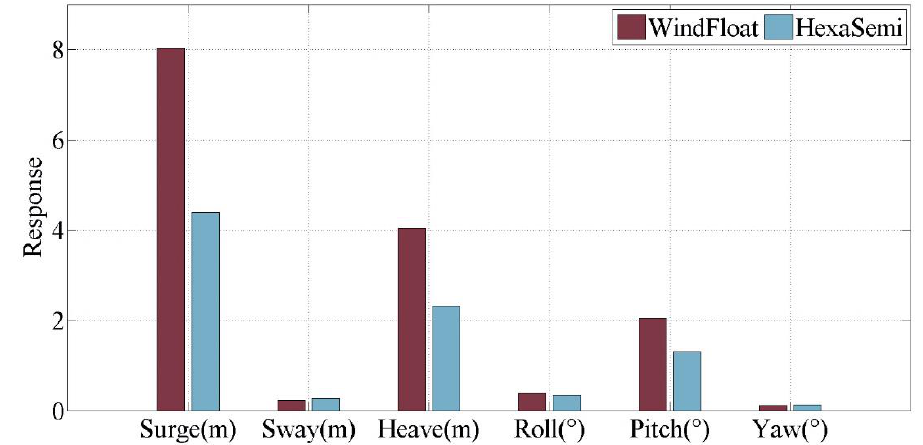
Figure 15. Comparison of 6-DOFs significant responses between the WindFloat-type platform and HexaSemi under a storm condition.